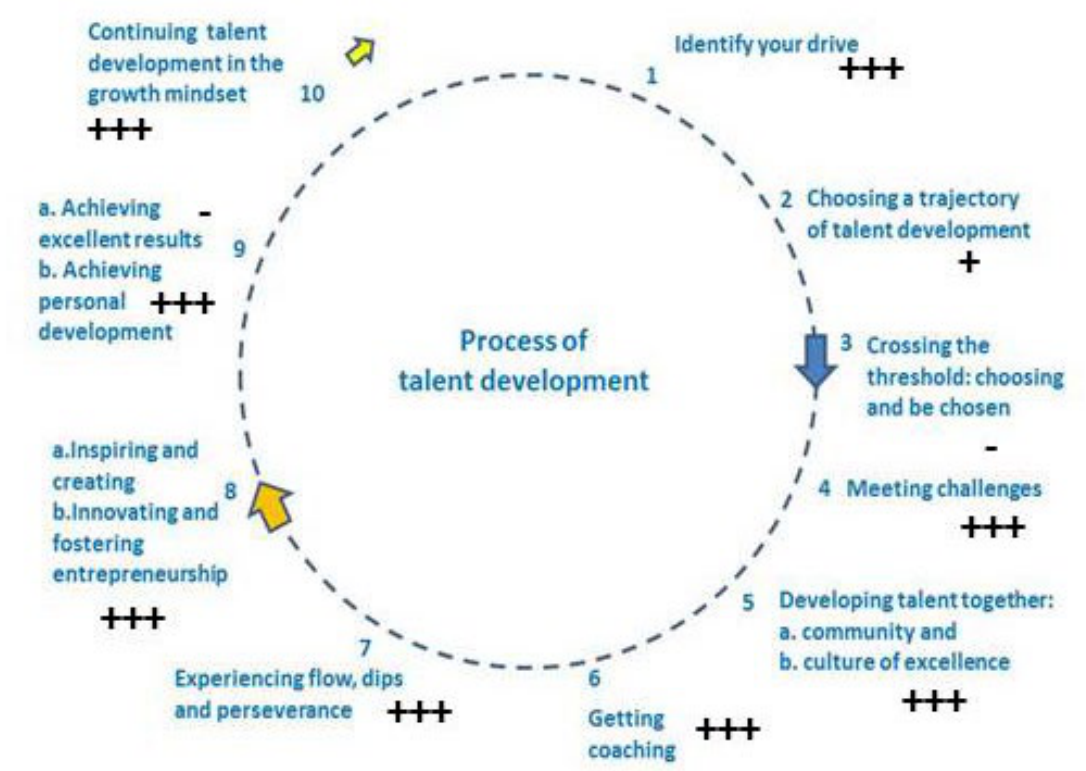
Figure 1: Circle of Talent Development in relation with the good practice ‘Facilitator training for the Saxion Top Talent Innovation Days’ with the teacher’s